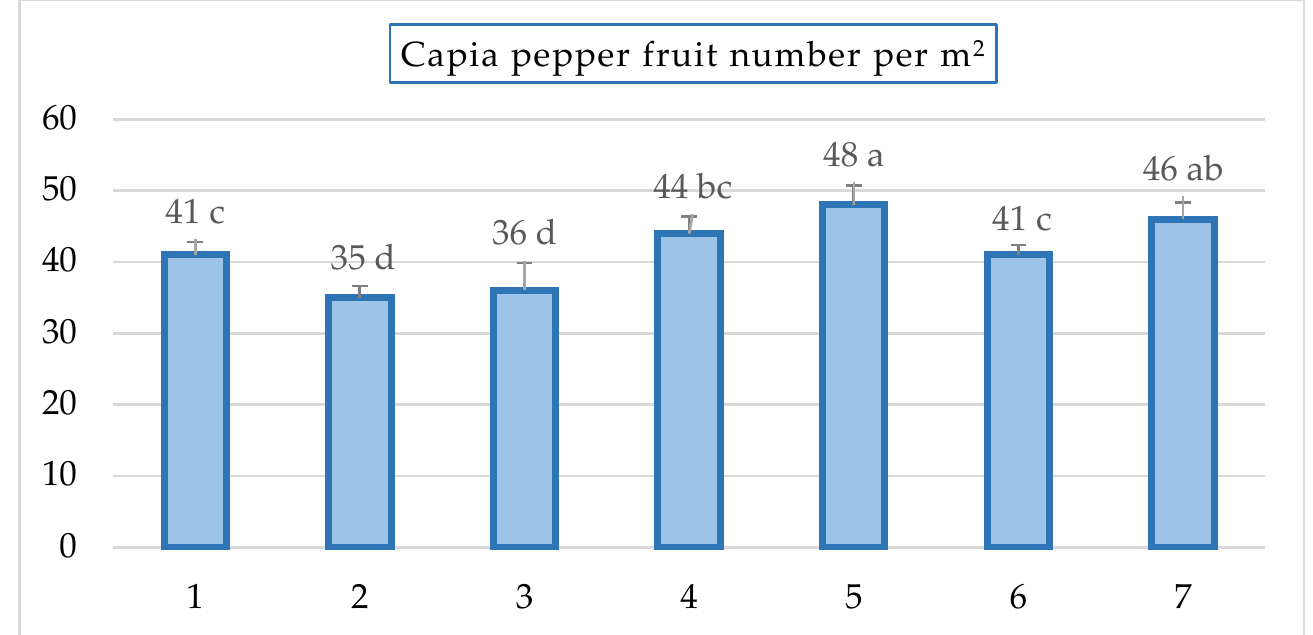
Figure 4. Effects of the bio-fertilizers on total fruit number of soilless-grown capia pepper under reduced mineral fertilizers in the Mediterranean climate in spring greenhouse conditions. 1:100% MF, 2:60% MF + PGPR, 3:60% MF + AMF, 4:60% MF + PGPR + AMF, 5:80% MF + PGPR, 6:80% MF + AMF, 7:80% MF + PGPR + AMF. MF: mineral fertilizer; PGPR: plant-growth-promoting rhizobacteria; AMF: arbuscular my- corrhizal fungi. Different letters within a column indicate significant differences, LSD 0 . 05 : 4.119, p : ˂ 0.001. Table 4. Effects of the treatments on the physical properties of capia pepper fruit.